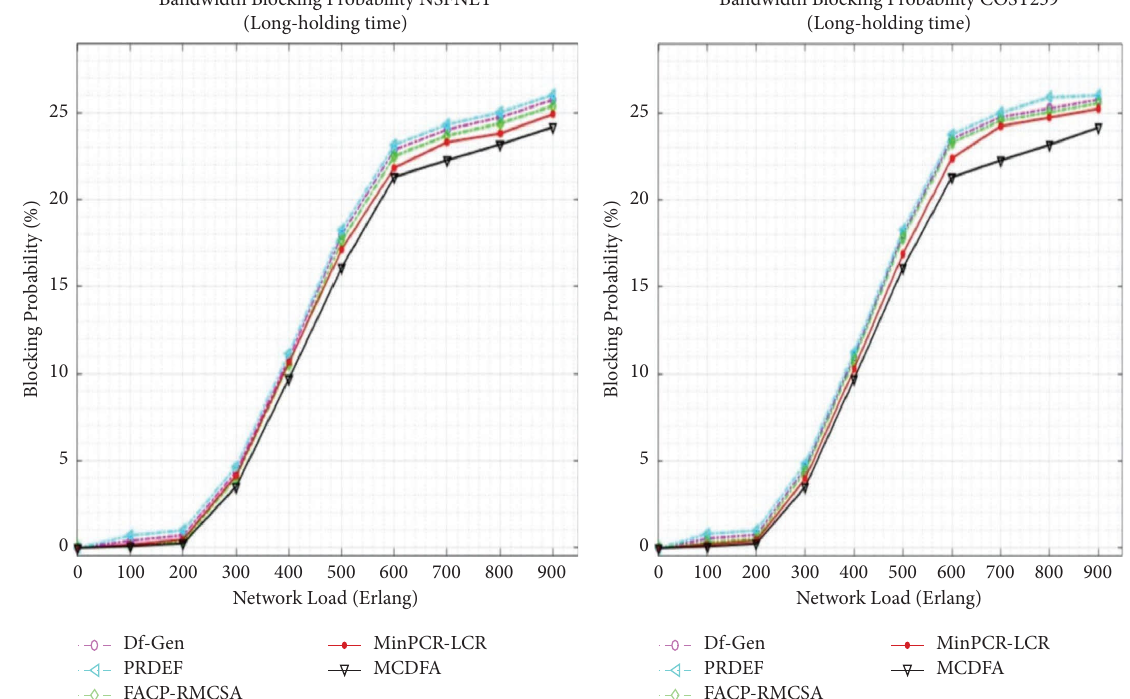
Figure 9: Te blocking probability % for NSFET and COST239 under long holding time arrivals